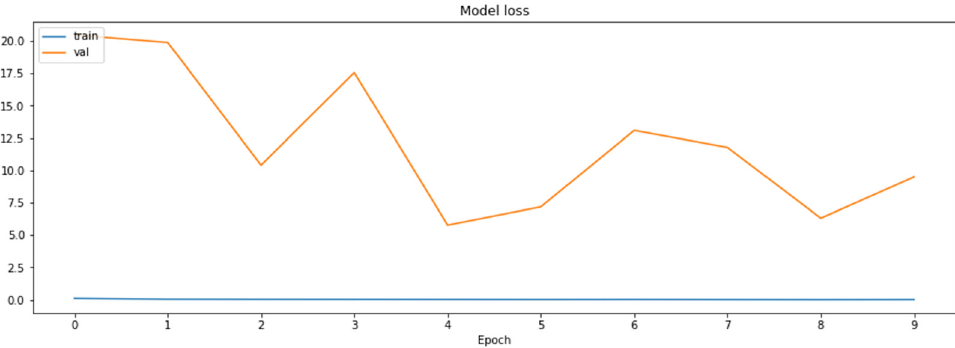
Figure 15. The loss function values for the validation datasets obtained during the regular training of